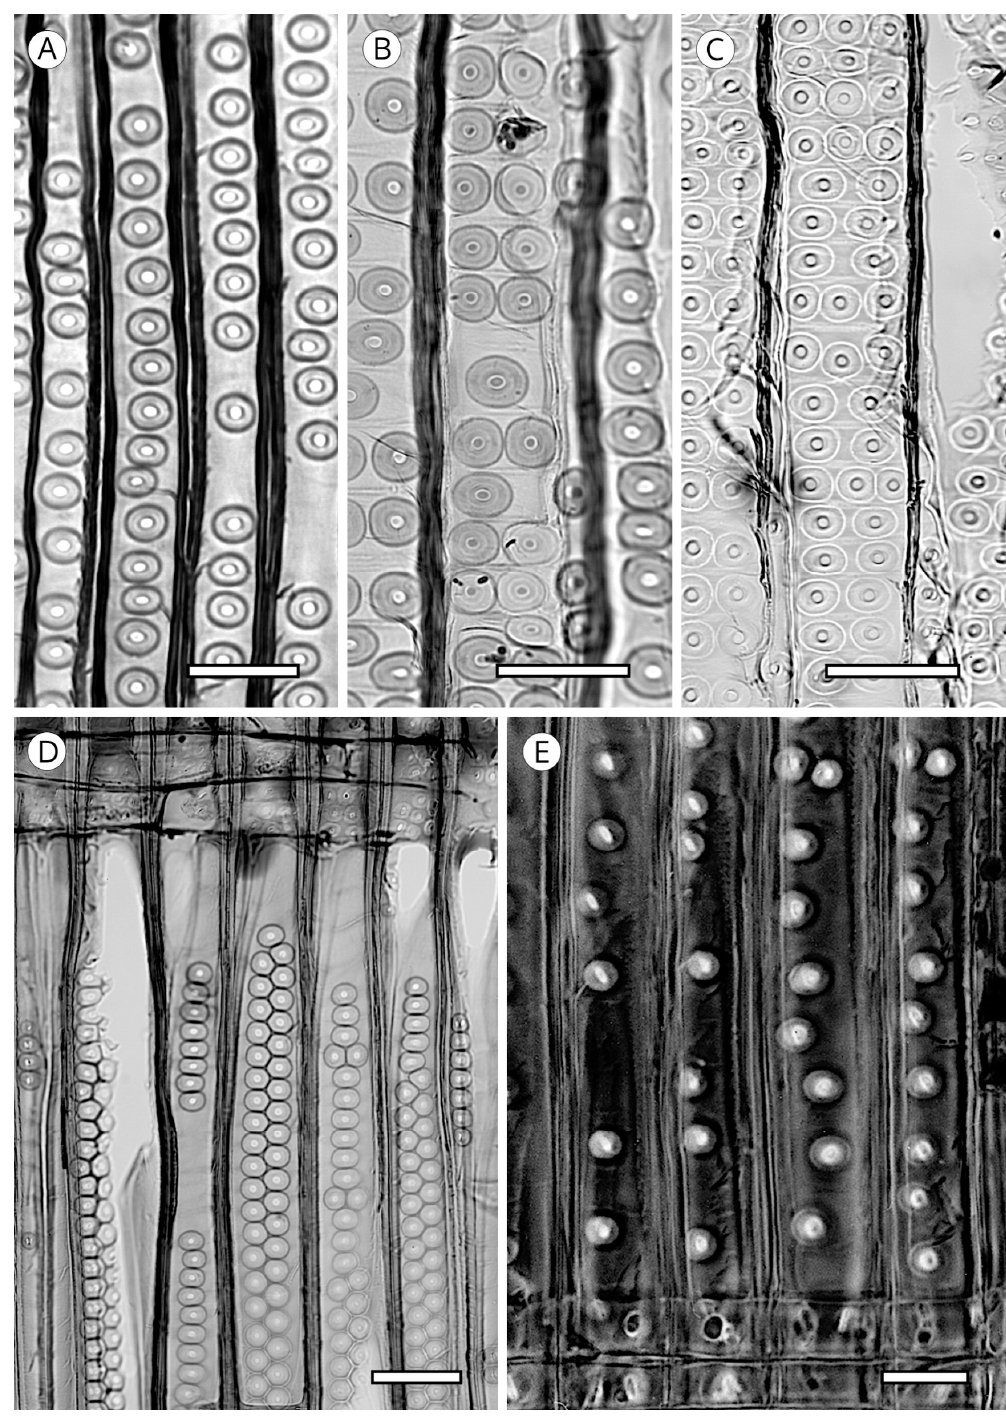
Figure 13. Pit arrangement. ( A ) Uniseriate in Abies fraseri (Pursh) Poir.; ( B ) Biseriate in opposite arrangement in Pinus arizonica Engelm.; ( C ) Multiseriate in Taxodium distichum (L.) Rich.; ( D ) Biseriate alternate and polygonal in Araucaria columnaris (G.Forst.) Hook.; ( E ) Pits in radial wall less than half tracheid diameter in Dacrydium elatum (Roxb.) Wall. ex Hook. Scale bars. ( A – D ) = 50 μ m; ( E ) = 25 μ m.